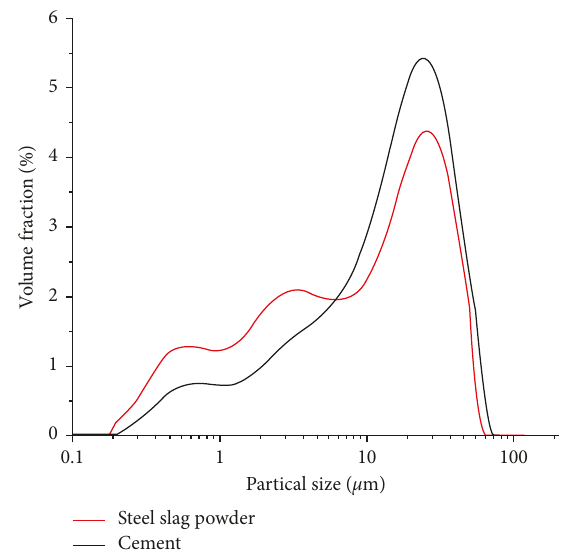
Figure 1: The particle size distributions of the cement and steel slag powder.